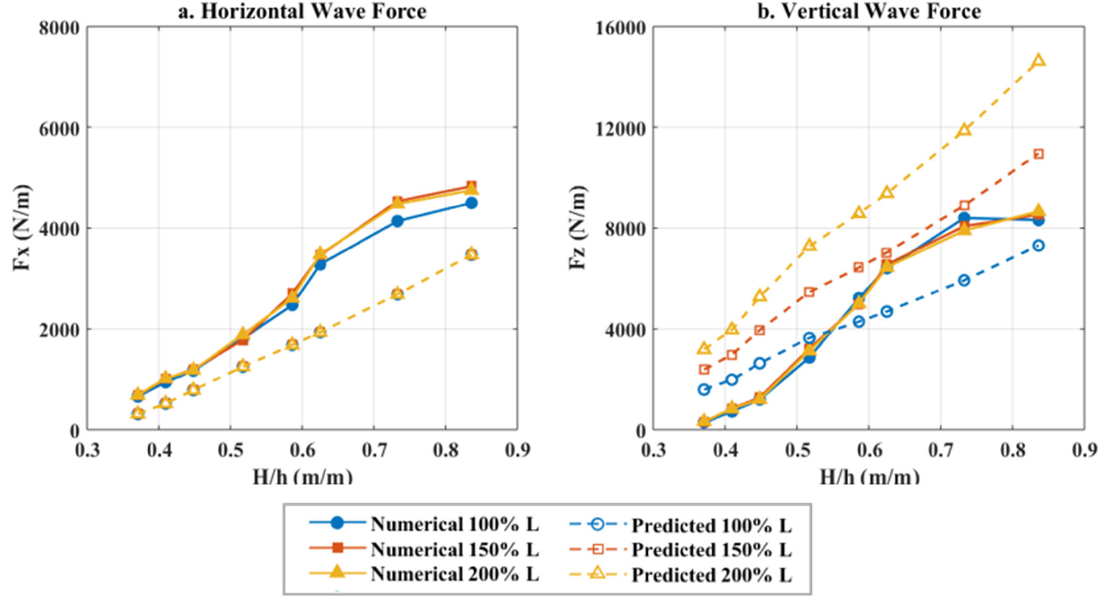
Figure 20. Maximum wave forces vs. the normalized wave height for different bridge widths, obtained from numerical simulations and predicted by the simplified equations of Azadbakht and Yim [9].